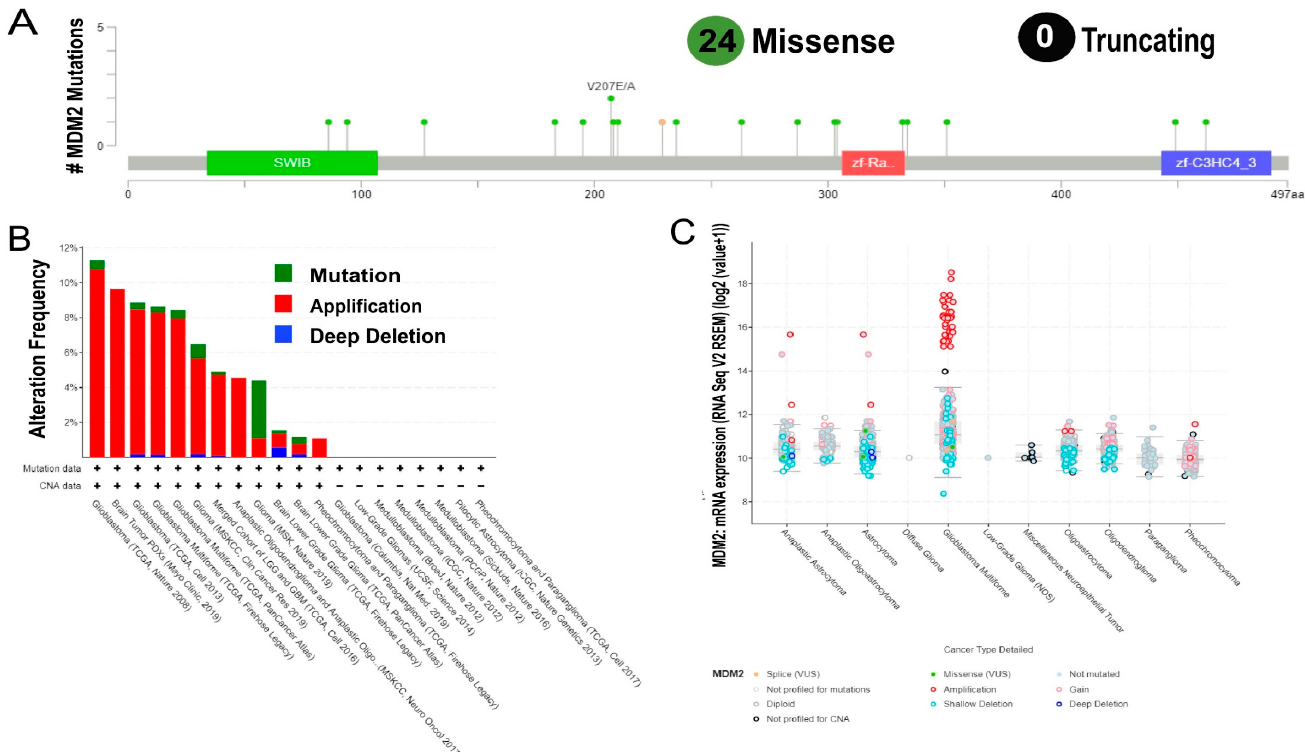
Figure 5. Representation of the genetic alterations in MDM2 protein sequences because of LGG progression enhancement. ( A ) A lollipop plot was used to identify 28 mutation variants in the MDM2 protein sequence. ( B ) In a bar diagram, two types of MDM2 modification frequencies were presented across distinct LGG research. ( C ) MDM2 expression levels were examined in relation to several classifications of genetic changes using graphical plots based on the RNA seq V2 relative standard deviation of the mean scale (RNA seq V2 RSEM).